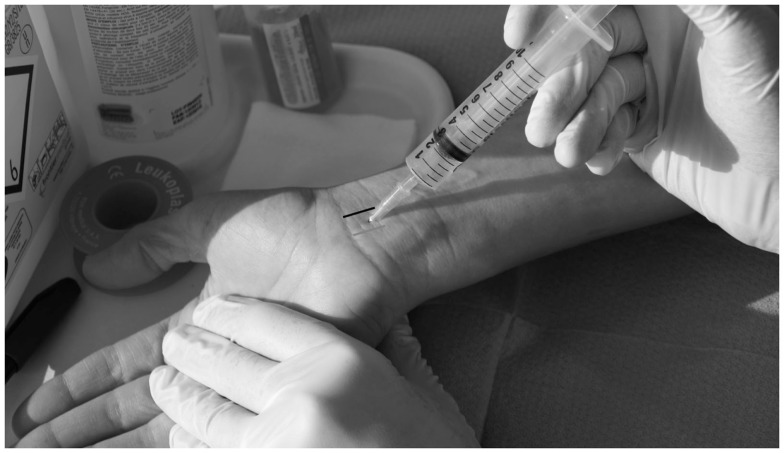
Steroid injection. Using a sterile technique, methylprednisolone triamcinolone acetate (longer half-life) with 1 mL of 1% lidocaine is injected using a 25 gage, 1.5″ needle just proximal to the wrist crease, usually between the palmaris longus (gray line) and the flexor carpi ulnaris (black line), between 30° and 45° angle. Disproportionate pain, blood on aspiration or resistance requires immediate adjustment of the needle position (to avoid nerve damage or intravenous/intratendinous injection).